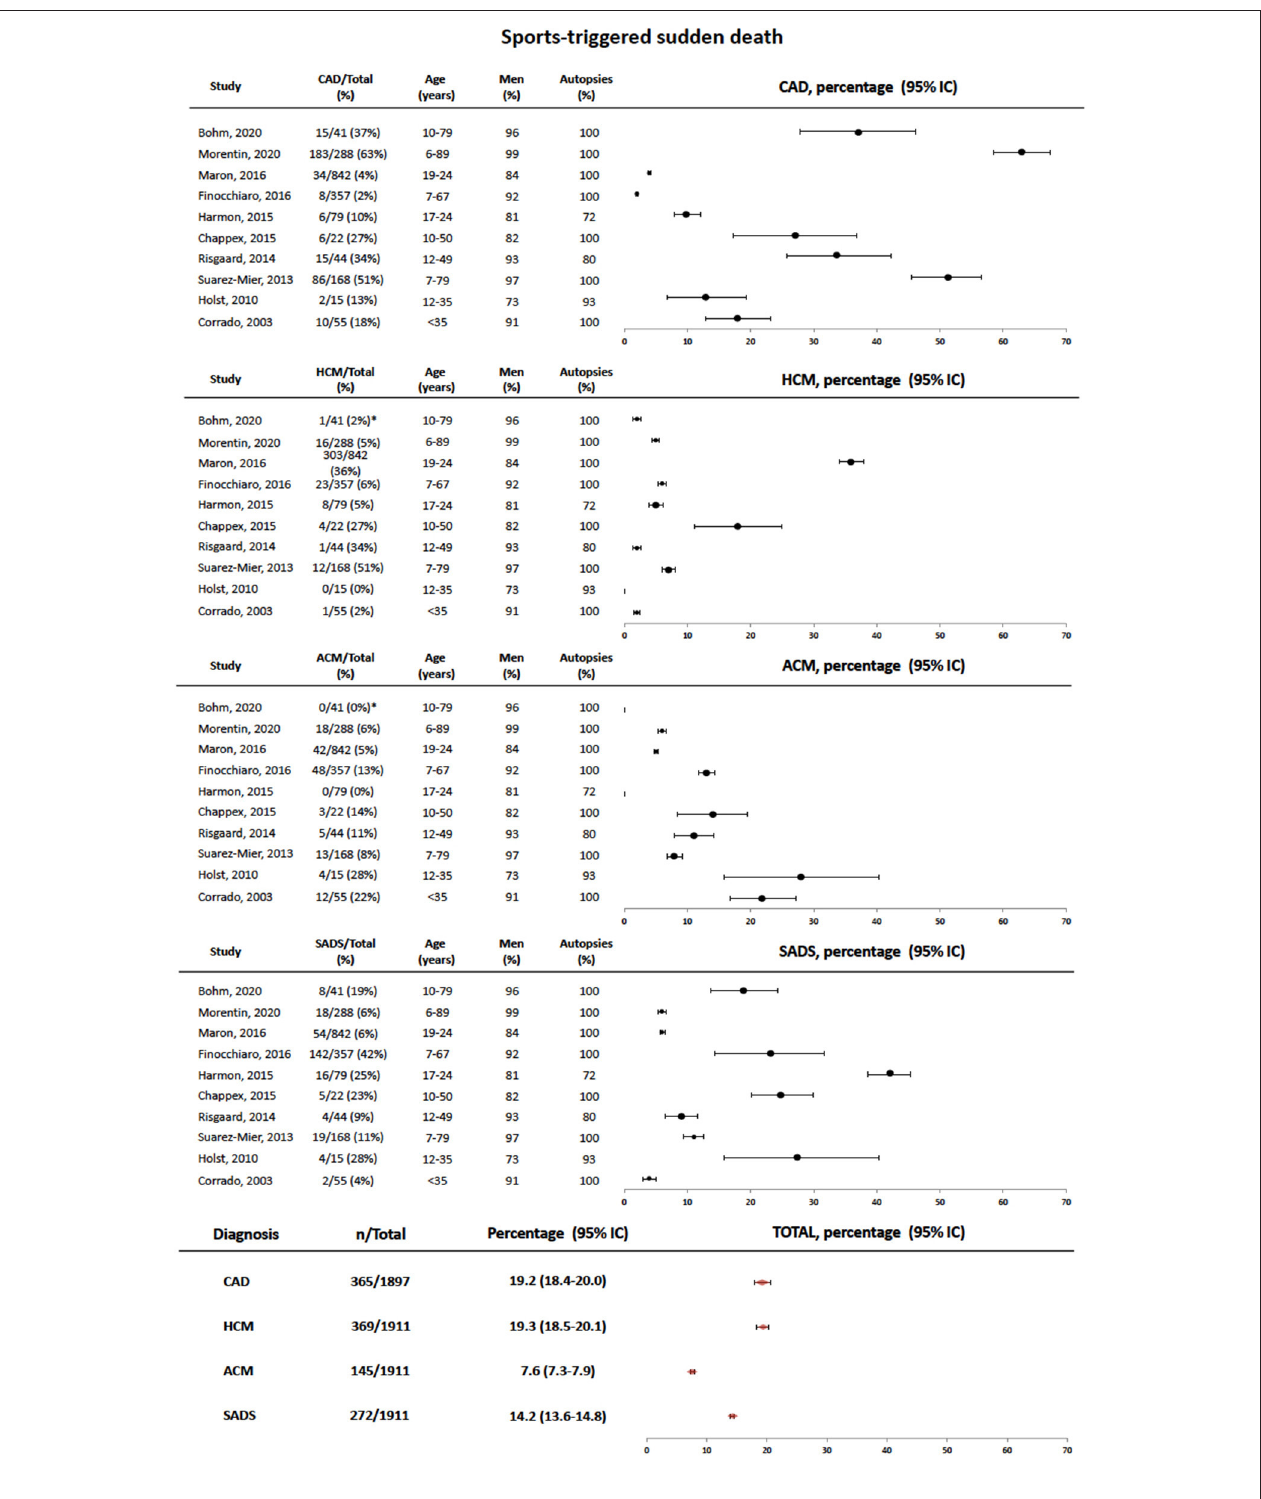
FIGURE 3 | Forest plot showing pooled data of the causes of sports-triggered sudden cardiac death in different series referenced in the text. At the bottom, total estimates are provided for each diagnosis. SCD, sudden cardiac death; CAD, coronary artery disease; SADS, sudden arrhythmic death syndrome; HCM, hypertrophic cardiomyopathy; ACM, arrhythmogenic cardiomyopathy. * The causes of death can be only retrieved form the 41 cases of sports-related sudden death cases with autopsy.